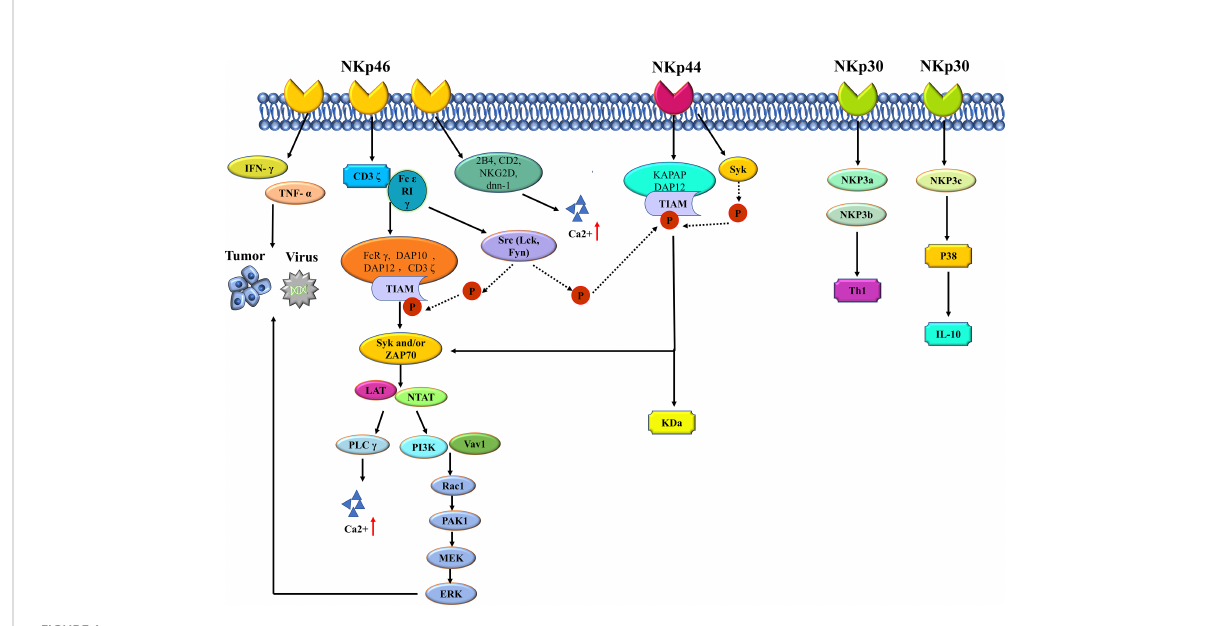
FIGURE 1 The mechanism of NCR protein of NK